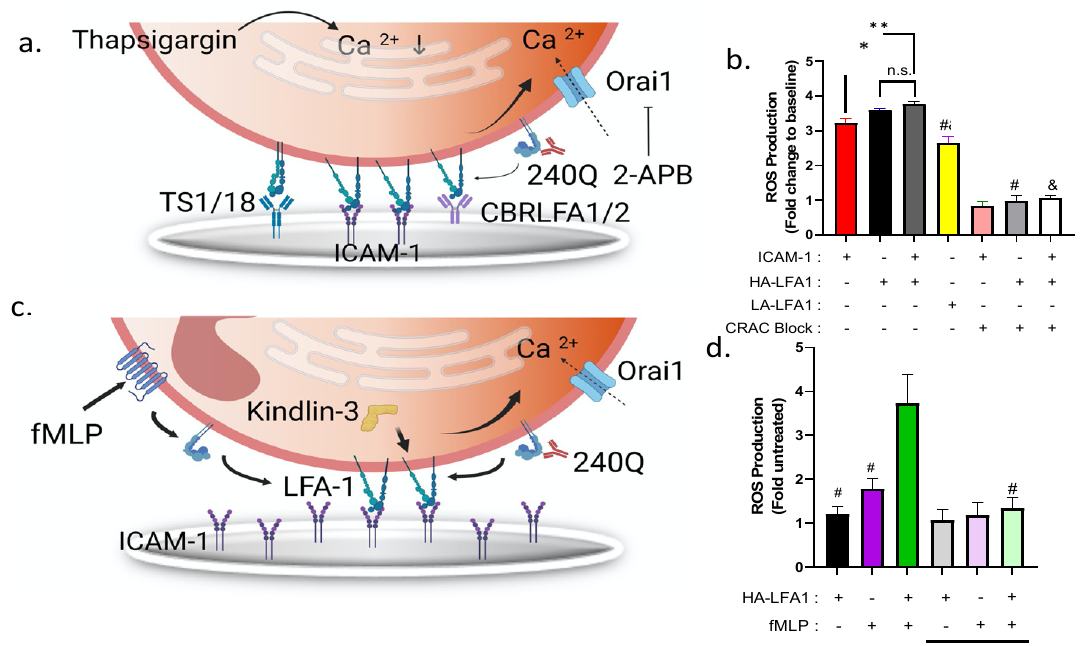
Figure 5. High-affinity β 2 -integrin potentiates superoxide production via signaling of kindlin-3- mediated Ca 2+ influx. ( a ) Schematic of ROS activity in freshly isolated neutrophils treated with thapsigargin to deplete cytosolic Ca 2+ and stimulated by addition of buffer containing 1 mM Ca 2+ and, where denoted, 240Q to induce HA β 2 -integrin before addition to well substrates coated with allosteric antibody to induce HA β 2 -integrin (CBRLFA1/2), LA β 2 -integrin (TS1/18), or ICAM-1 + 240Q as denoted. CRAC channel activation is stimulated by addition of 1.5 mM CaCl 2 and blocked in the presence of 2-APB. ( b ) Plot of the maximum increase in ROS activity normalized by baseline level of unstimulated cells attached to ICAM-1 for the indicated conditions over 100 min of shear mixing. All data are represented as mean +/- SEM ( n = 3, * and ** denotes significance compared to ICAM-1 alone p < 0.05 and p < 0.01 respectivelyt. # denotes significance compared to HA β 2 -integrin alone. & denotes significance compared to ICAM-1, p < 0.01). ( c ) Schematic of dHL-60 neutrophils co-stimulated via fMLP and allosteric activation of HA- β 2 -integrin by addition of 240Q to mediate Ca 2+ entry dependent upon kindlin-3 and Orai1. ( d ) Histogram of maximum increase in ROS pro- duction in WT and siRNA to knockdown kindlin-3 activity, normalized by untreated dHL60. All data are represented as mean +/- SEM ( n = 3, # significance to HA-LFA-1+ fMLP condition, p < 0.01).